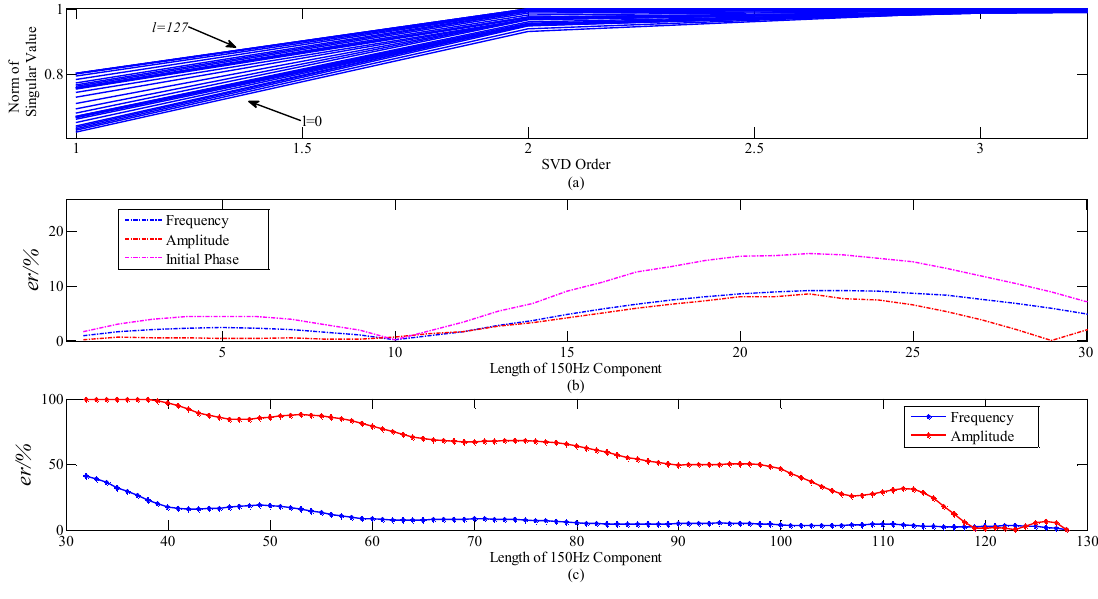
Figure 2. ( a ) Norm of singular value with different l ; ( b ) The er of 50 Hz component with l increasing; ( c ) The er of 150 Hz component with l increasing.